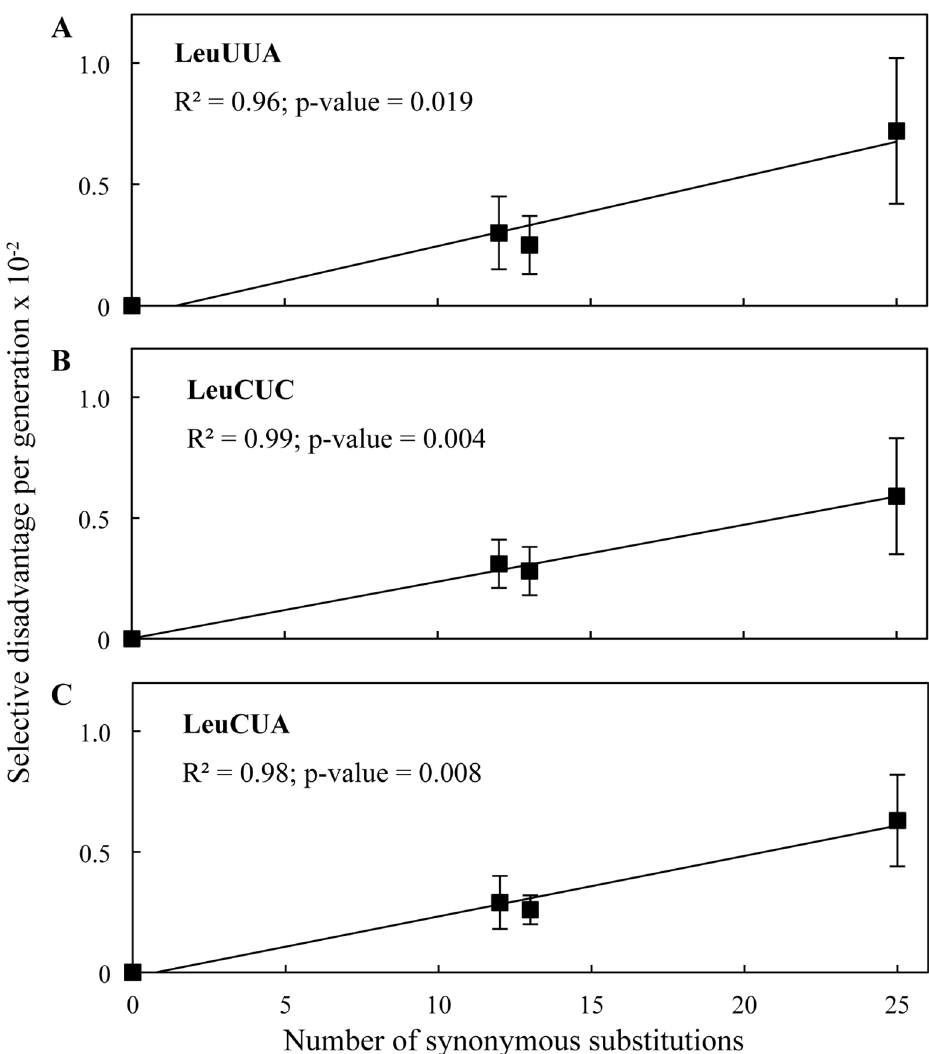
Fig 2. Correlation between the number of synonymous substitutions and the resulting selective disadvantage. Selective disadvantage as a function of the number of synonymous substitutions for the leucine codons (A) UUA, (B) CUC and (C) CUA. Results are shown as means ± 95% confidence interval. Black line indicates regression